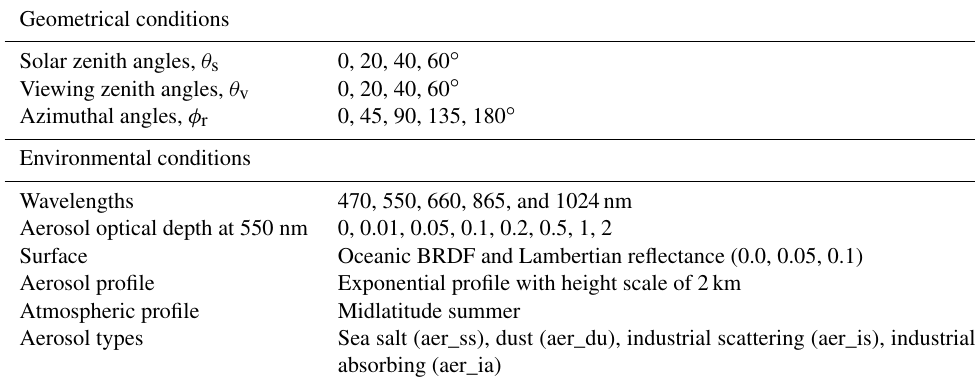
Table 2. Summary of the proposed geometrical and environmental conditions used in the simulations.